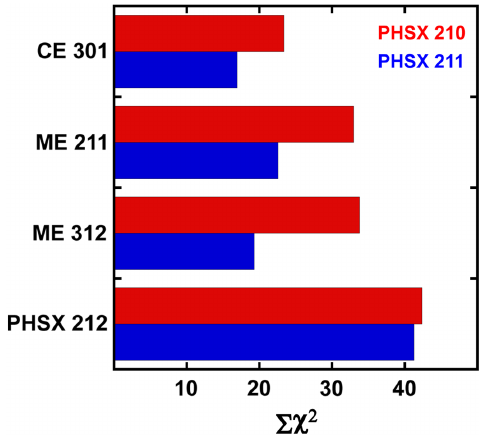
FIG. 8. Sum of χ 2 for grades of A or B in downstream courses from the fall semester of 2015 through the spring semester of 2018 by students who had completed PHSX 210 (red) or PHSX 211